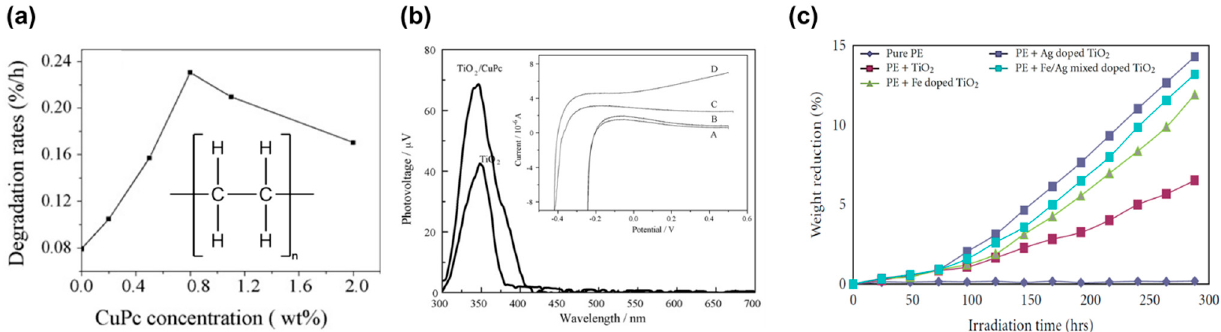
Figure 15. Photodegradation of PE. ( a ) CuPc concentration wt% dependent degradation rate. Inset: Chemical formula of PE. ( b ) Surface photovoltage spectroscopy spectra of TiO 2 and TiO 2 /CuPc photocatalyst. Inset: The I-V curves of different photocatalysts, i.e., TiO 2 /CuPc without irradiation (curve A), TiO 2 /CuPc under visible irradiation (curve B), TiO 2 under UV irradiation (curve C), and TiO 2 /CuPc under UV radiation (curve D) [72]; reprinted from [72] with permission from Elsevier. ( c ) Effect of simulated sunlight on the photocatalytic degradation of PE film [74].